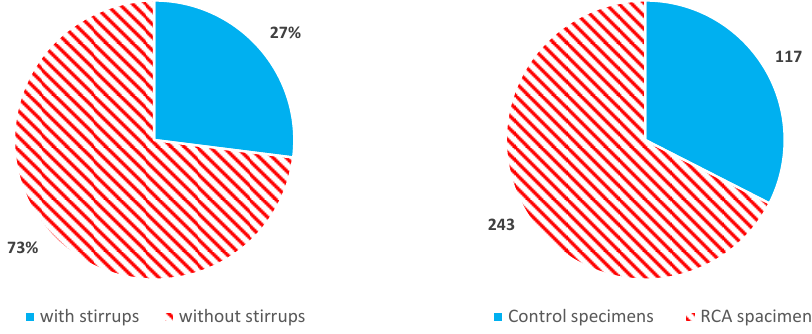
with stirrups without stirrups Control specimens RCA spacimens Figure 2. Share of beams with shear reinforcement and control Figure 2. Share of beams with shear reinforcement and control specimens.